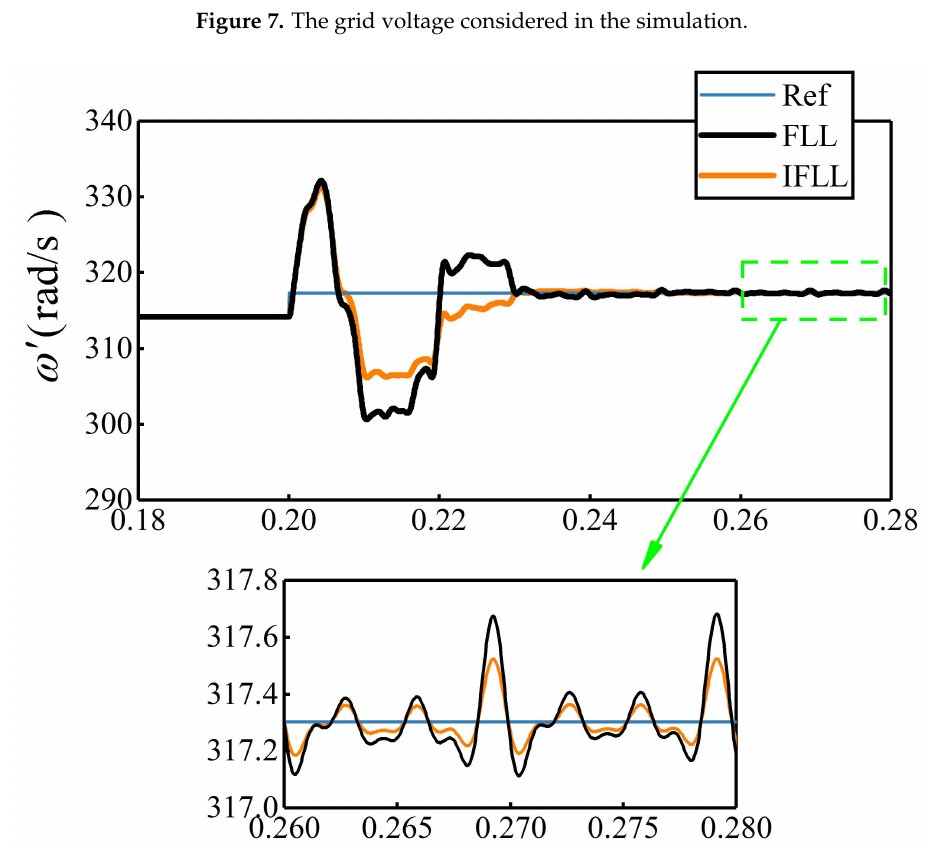
Figure 8. Estimated